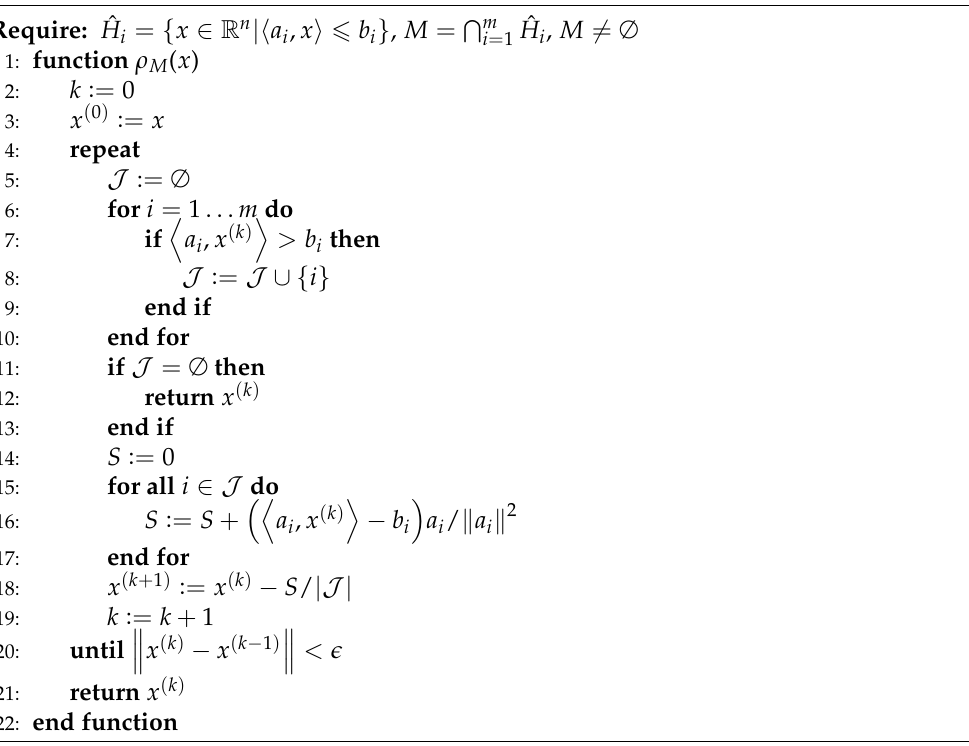
Algorithm 1 Calculating the pseudoprojection ρ M ( x ) .